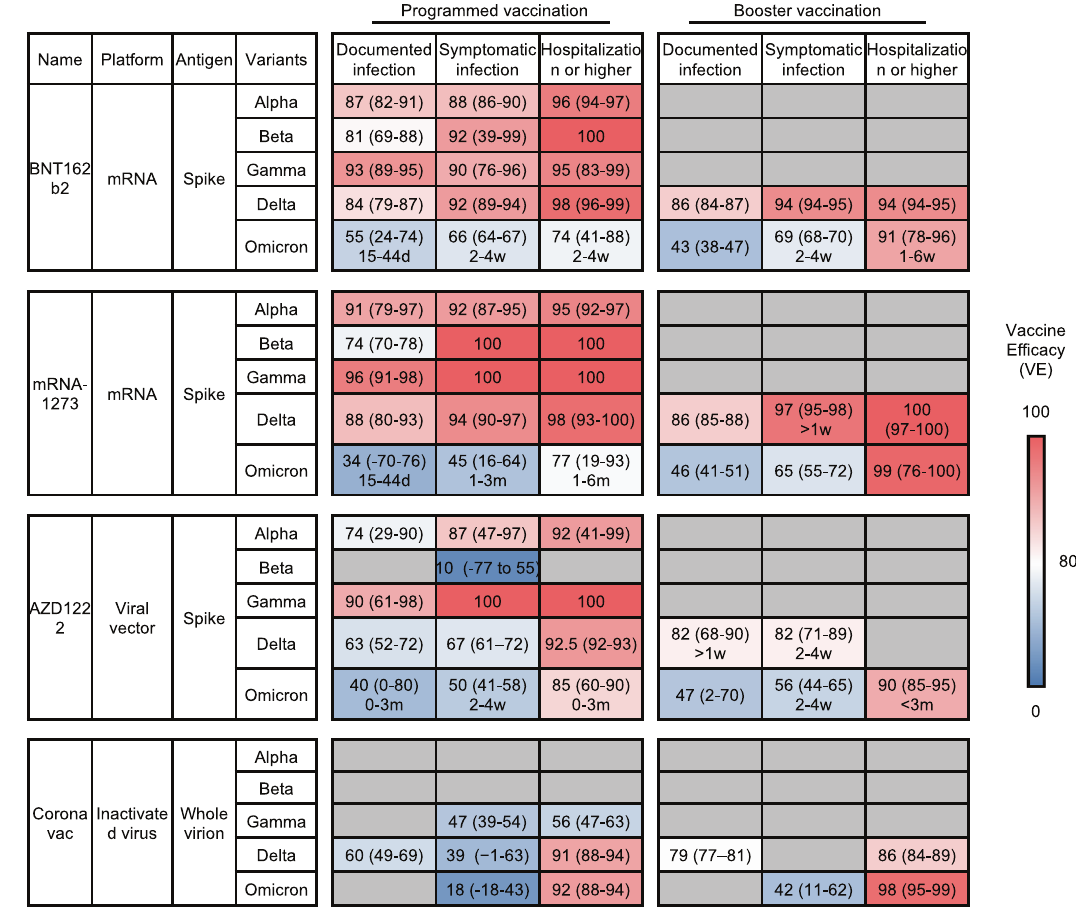
Fig. 10 The summary of vaccine ef fi cacy (VE) against infection from SARS-CoV-2 variants after programmed or booster vaccination. Three major outcomes are recorded, including documented infection, symptomatic infection, and hospitalization or more severe cases. Each vaccine ’ s average VE and 95% con fi dential interval (CI) against variants are listed. The average VE value is indicated in a red-to-blue color scale to represent the average protective ef fi cacy against each outcome. A bluer color indicates worse protection from the outcome of